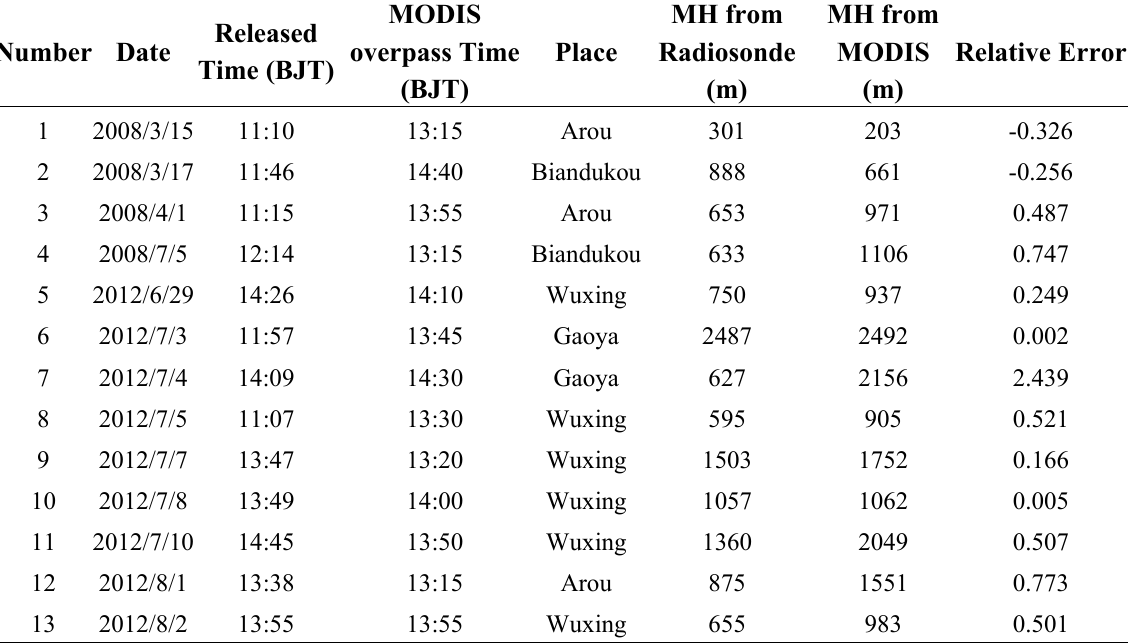
Table 1. Comparison between the MH calculated from radiosonde data and that from MODIS data for 13 days in 2008 and 2012 for the Heihe river